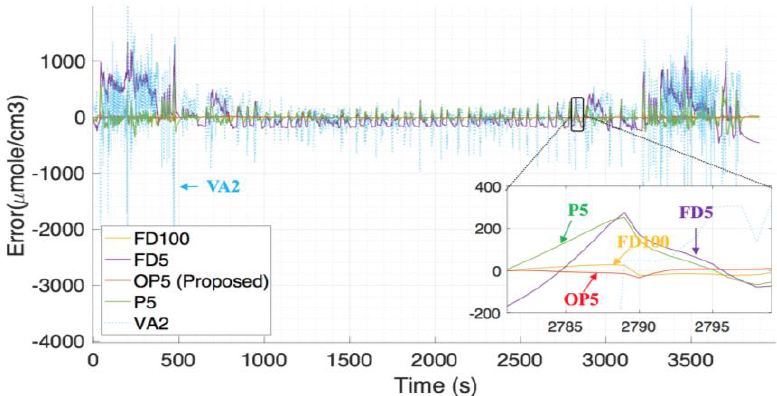
Figure 14. Time-domain simulation of different algorithms based on FDS.